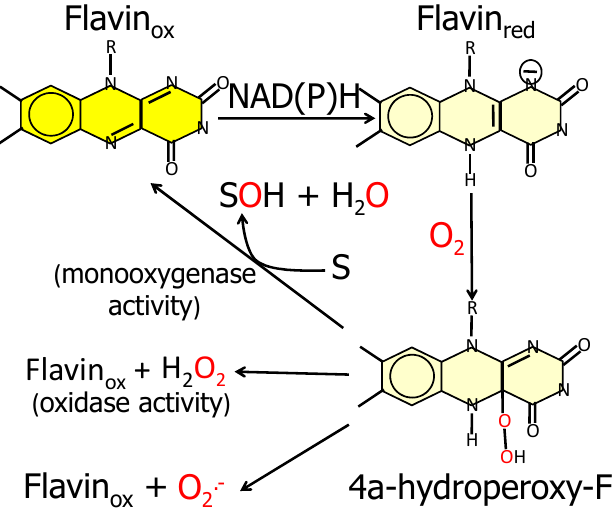
Figure 3. General scheme of the catalytic activities of FAD-dependent monooxygenases (hydroxylases)